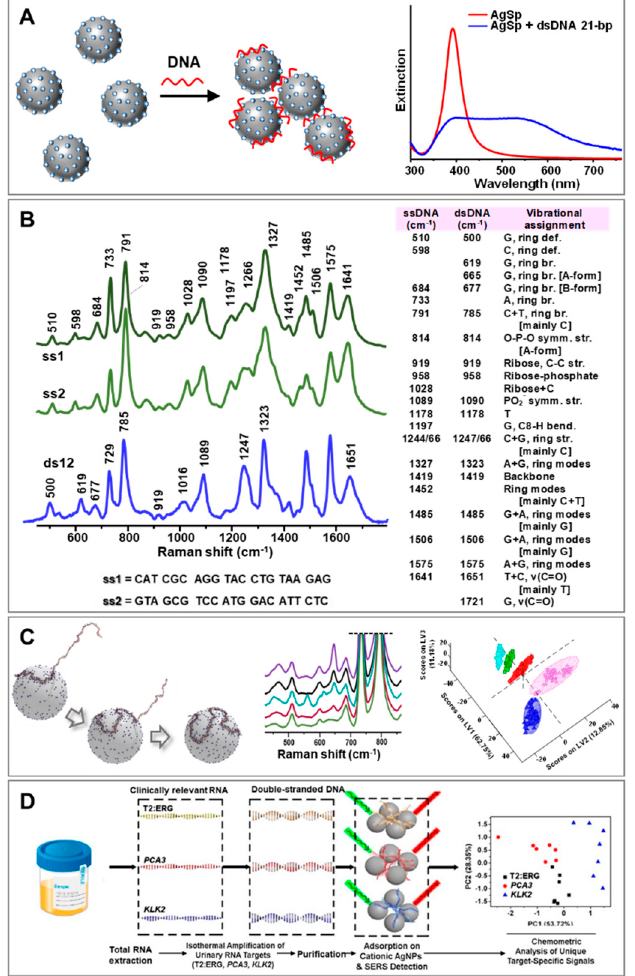
Figure 2. ( A ) Outline of NA-mediated assembly of cationic spermine-coated silver colloids (AgSp) into stable clusters in suspension and the representative extinction spectra of the nanomaterials before and after the addition of a 21-bp duplex. Adapted with permission from [37]. Copyright 2015 WILEY-VCH. ( B ) SERS spectra of two 21-nt complementary ssDNAs (ss1 and ss2) and their corresponding duplex (ds12). A table with the vibrational assignments is also included. Adapted with permission from [29]. Copyright 2018, Royal Society of Chemistry. ( C ) Molecular dynamics simulation of the wrapping process of a 141-nt single-stranded DNA around a AgSp nanoparticle for low salt concentration, SERS spectra of 141-nt ssDNAs with single and double-point mutations in the 430–910 cm − 1 spectral range, and the resulting partial least-squares discriminant analysis (PLS-DA). Adapted with permission from [45]. Copyright 2017 WILEY-VCH. ( D ) Schematic of SERS detection of urine RNA prostate cancer biomarkers using AgSp colloids and pre-amplification of the target RNAs via reverse transcriptase-recombinase polymerase amplification (RT-RPA). Adapted with permission from [47]. Copyright 2018, American Chemical Society.